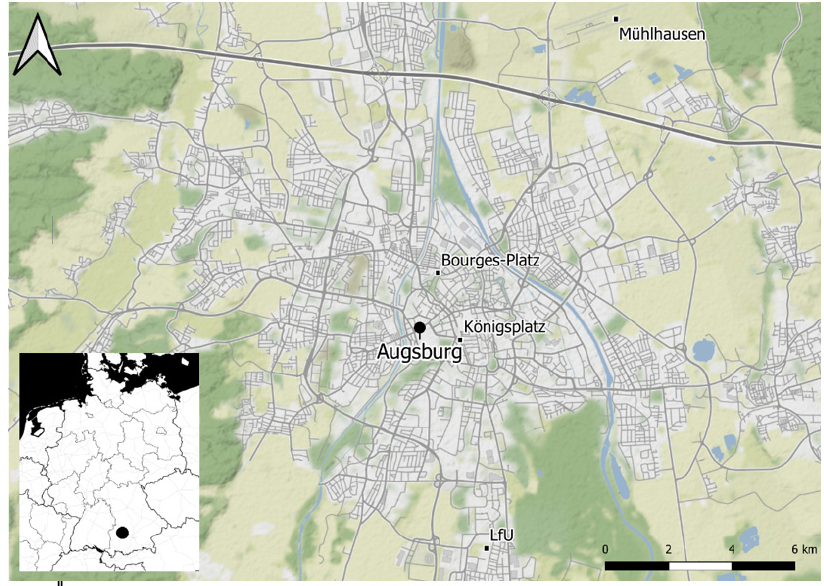
Figure 1. Location of meteorological and air quality measuring sites in Augsburg, Germany. Table 1. Included atmospheric predictors, corresponding measuring sites and measuring entities.